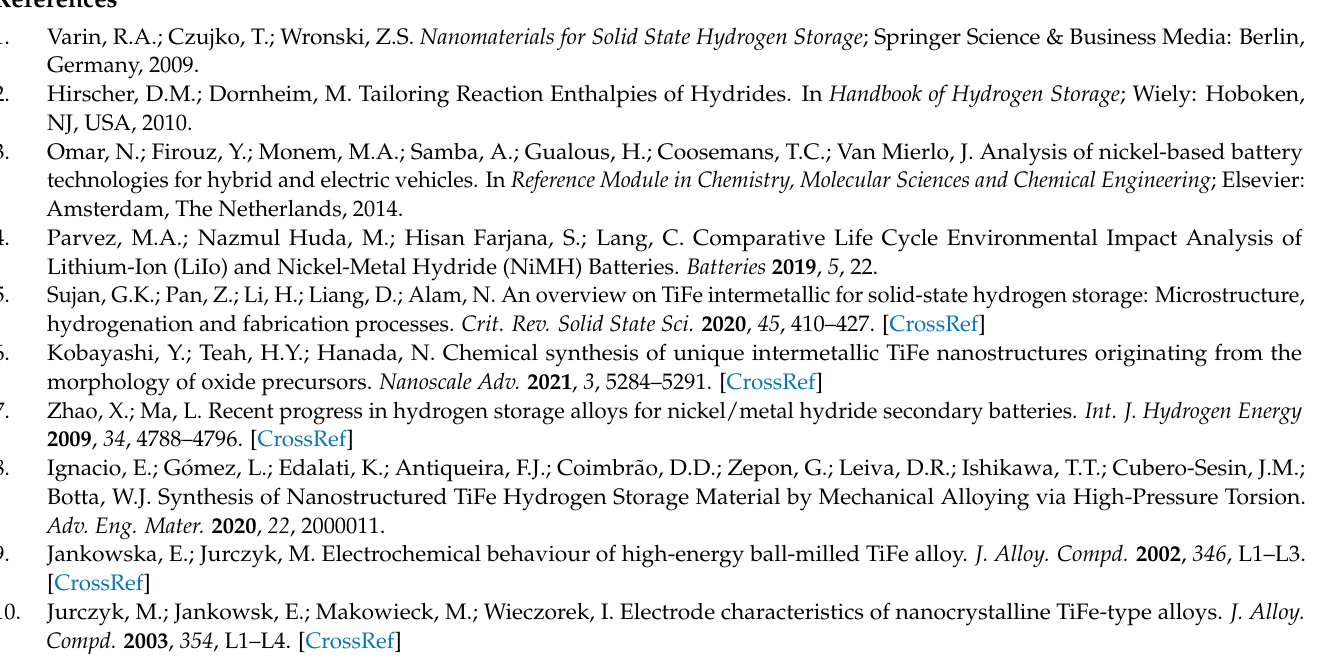
Figure S3: XRD pattern of the heat treated milled product exhibiting sharp peaks of TiFe intermetallic compound crystals; Table S1: Atomic and weight percentages of the elements in TiFe milled product after 60 h of